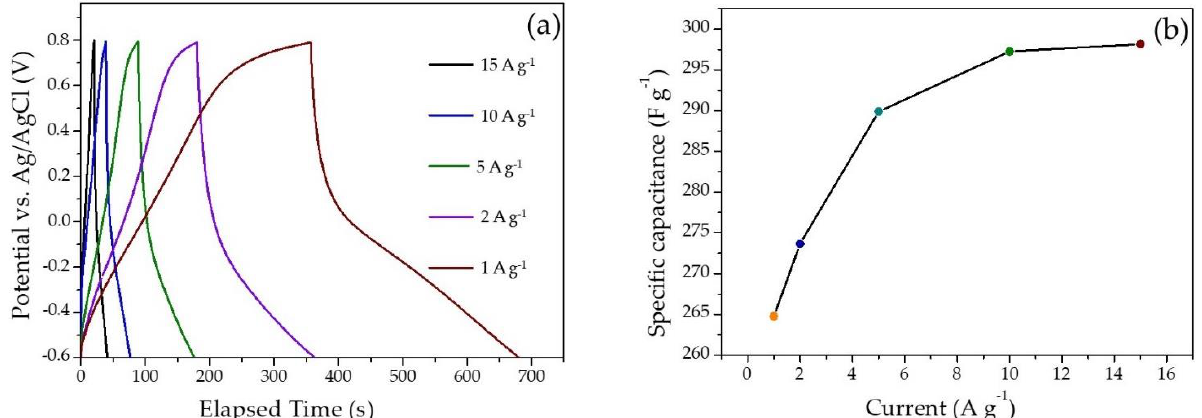
Figure 7. Electrochemical performance of the semi-polycrystalline polyaniline in aqueous electrolyte: ( a ) galvanostatic charge–discharge curves recorded at different current densities ranging from 1.0–15 A g − 1 ; ( b ) evolution of the specific capacitance with respect to the different current densities.